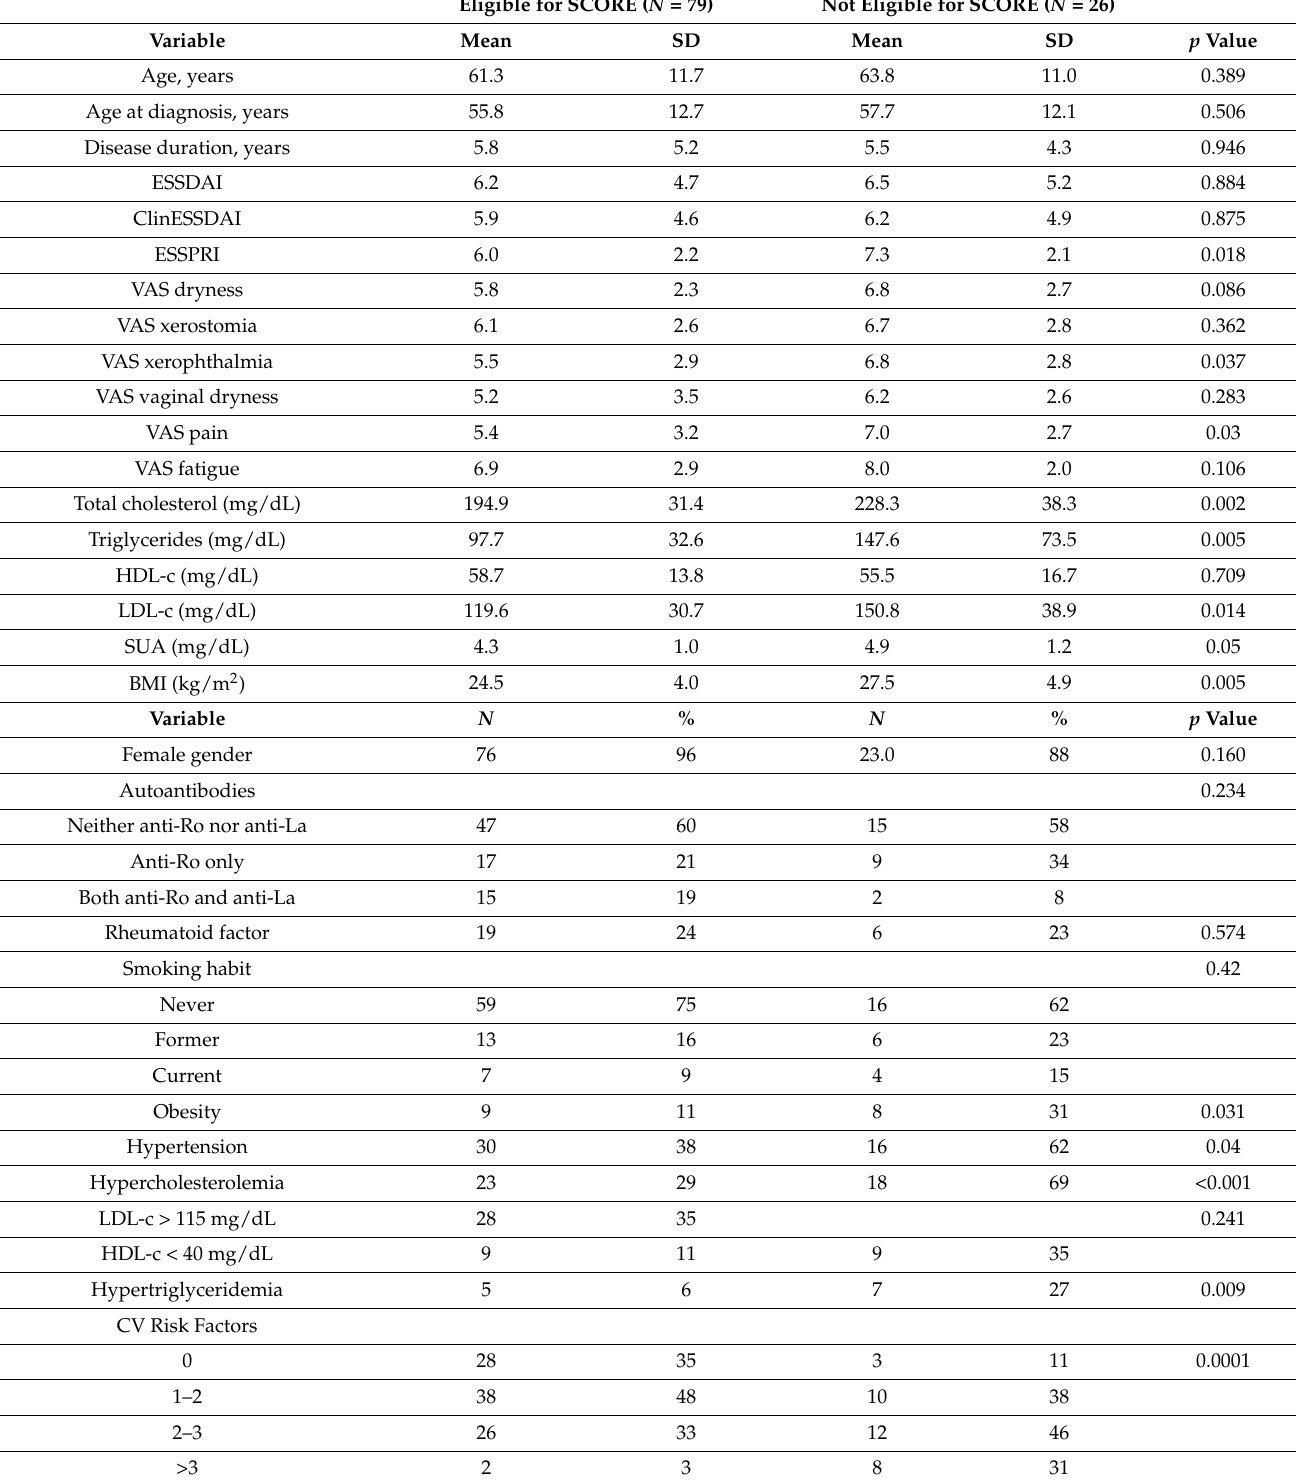
Table 5. Characteristics of patients eligible for SCORE calculation ( N =